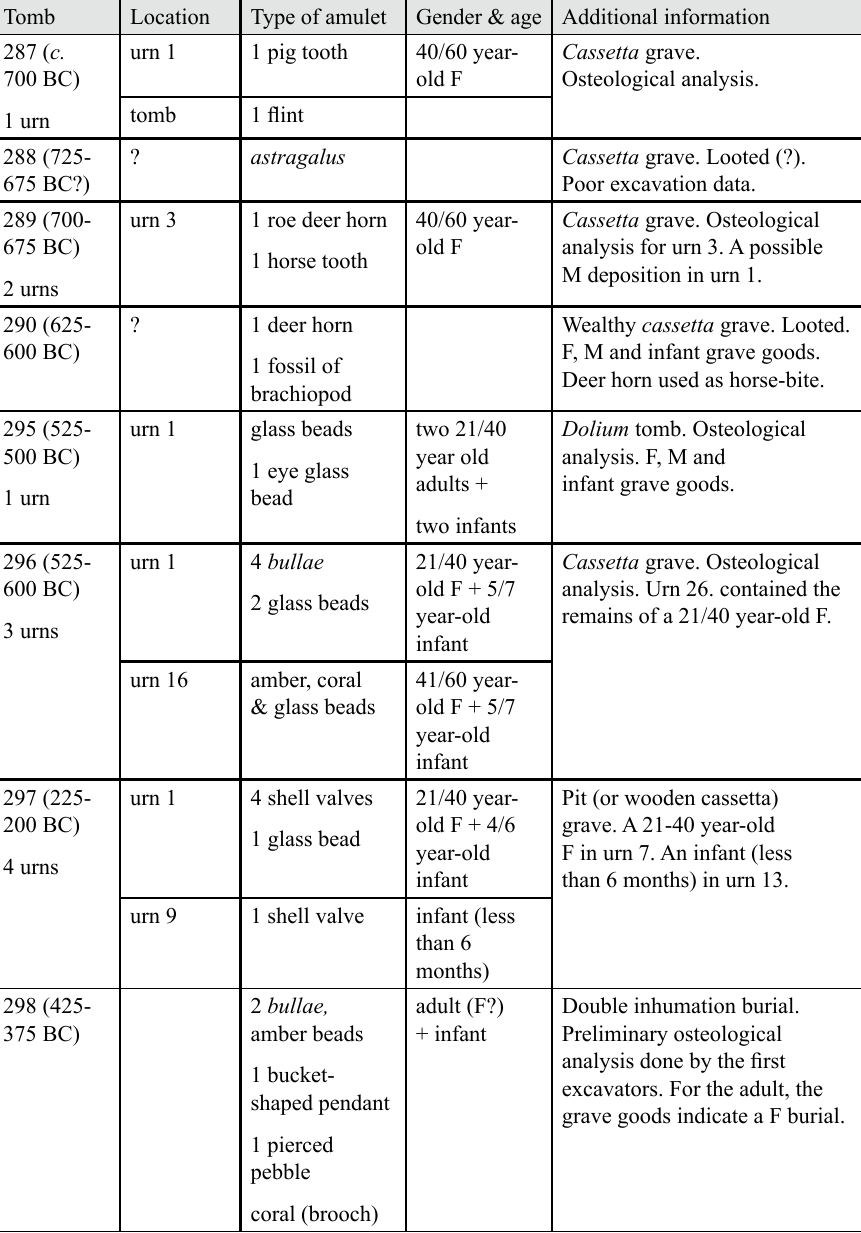
Table 2. Details of amulets found within